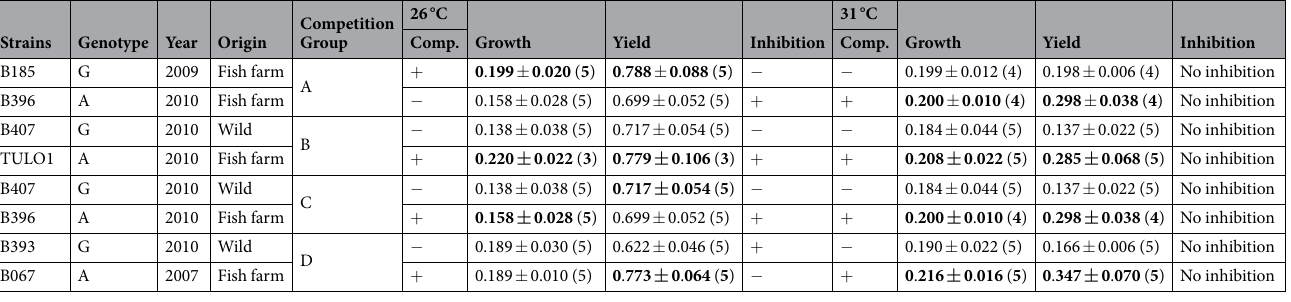
Table 1. Details of Flavobacterium columnare strains used in this study, and their performance in competition pairs (A–D, + indicates winner strain in competition). Growth and yield equals growth rate and yield measured in liquid medium, and inhibition ( + ) refers to which strain inhibited which in competition pairs. In bold: indicates which strains of a given pair has the fastest growth rate or highest yield at a given